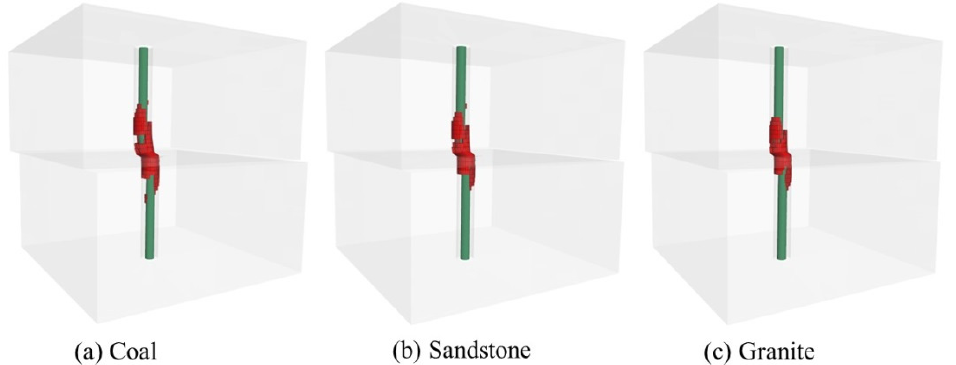
Figure 7. Distribution of plastic zones on anchoring agent.